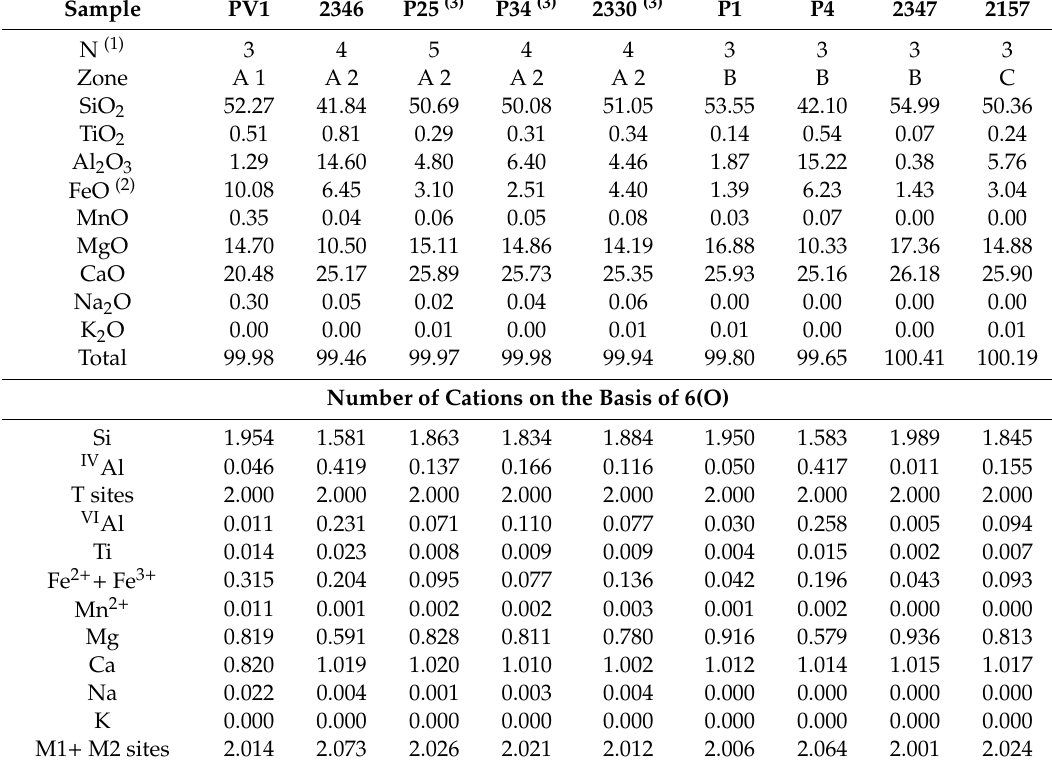
Table 6. Representative compositions of diopside, M ă gureaua Va¸tei